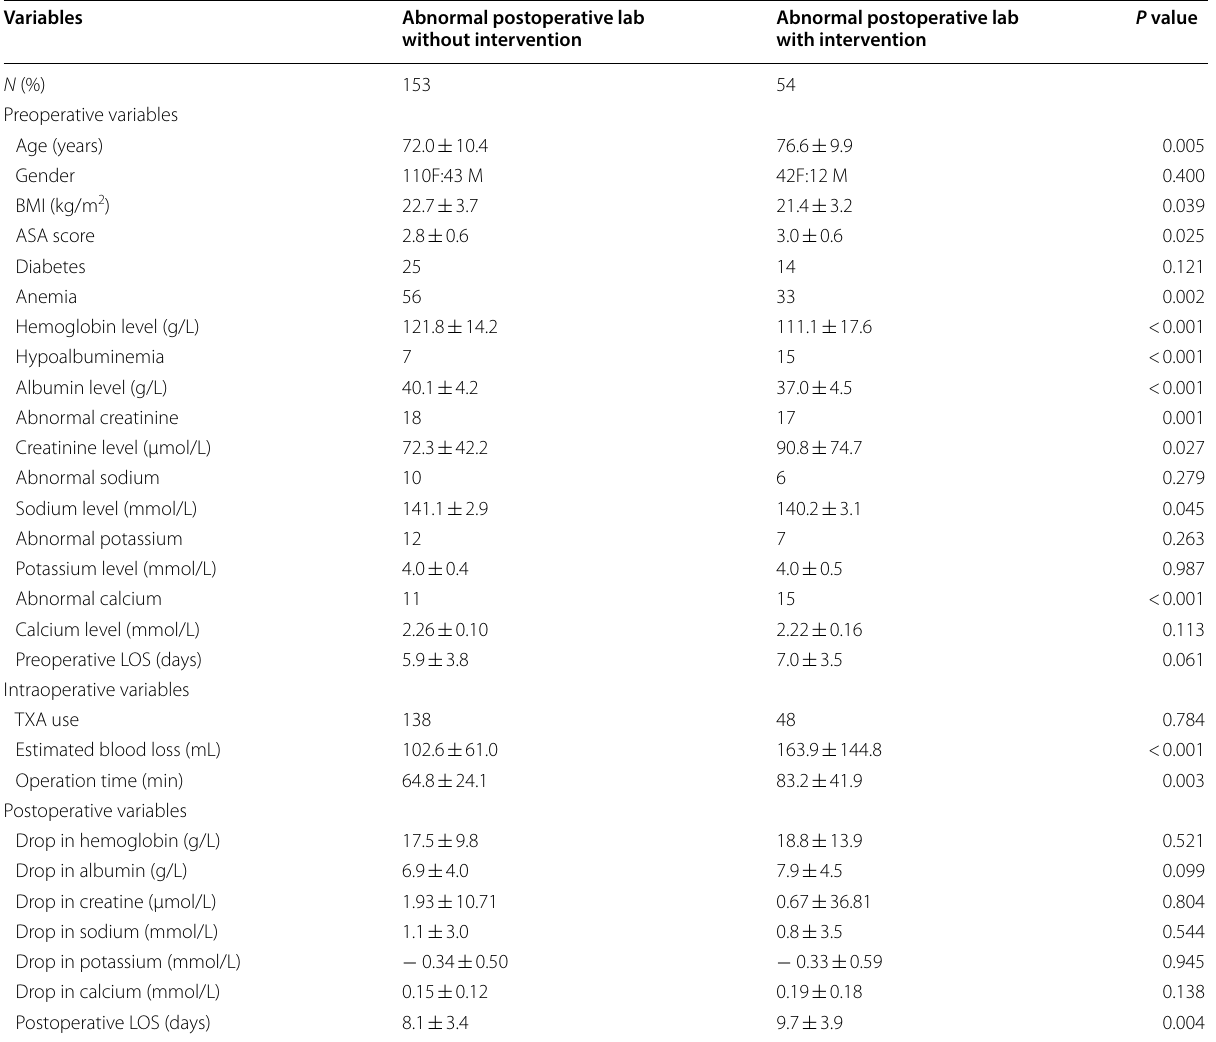
Table 3 Comparison of variables between patients with abnormal postoperative laboratory tests and with or without intervention